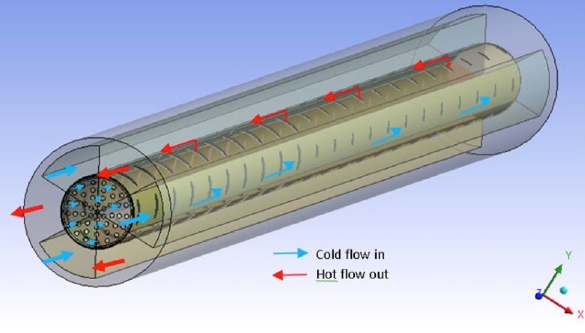
FIG. 4. Proposed pebble bed target for the Super Beam.